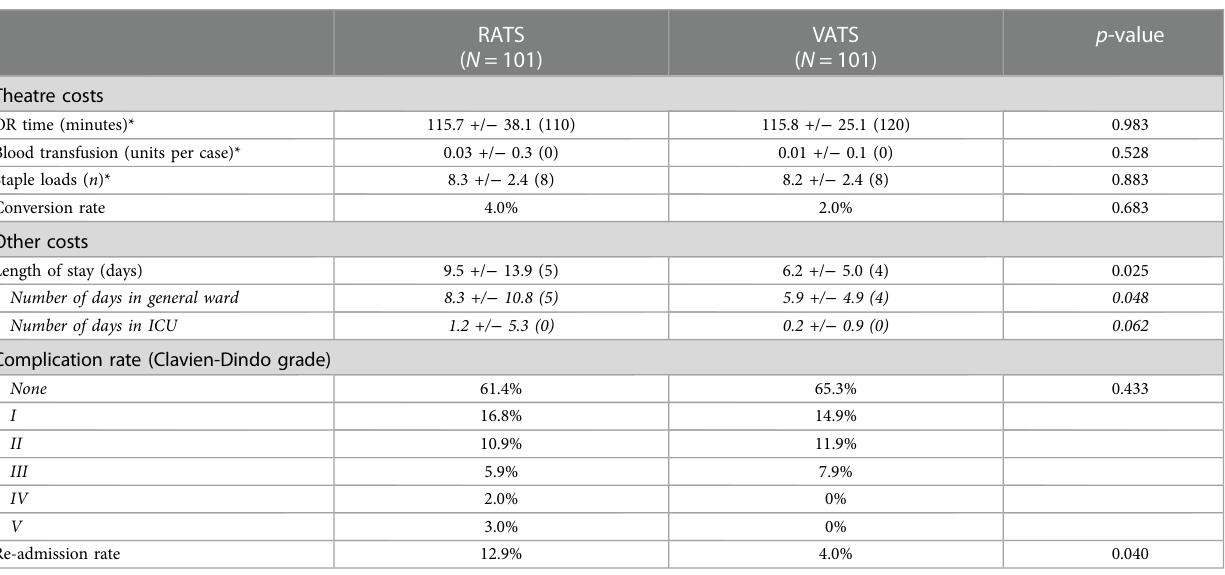
TABLE 5 Comparison of theatre and postoperative data from RATS and VATS lung resections.